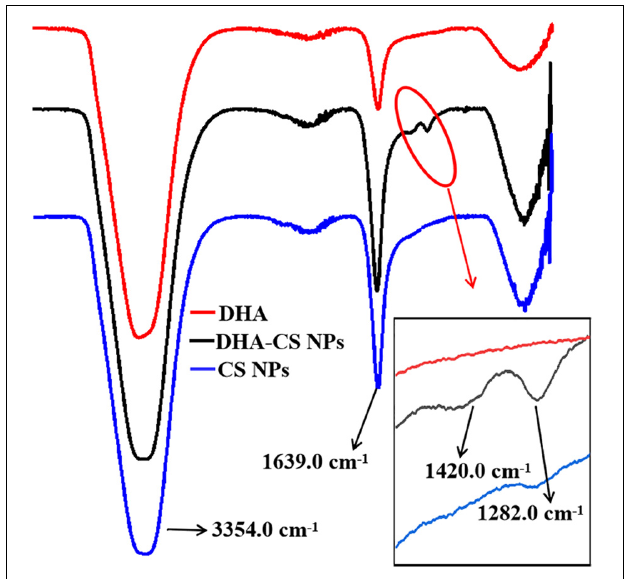
FIGURE 2 | FTIR spectra of DHA-CS NPs, CS NPs, and DHA.